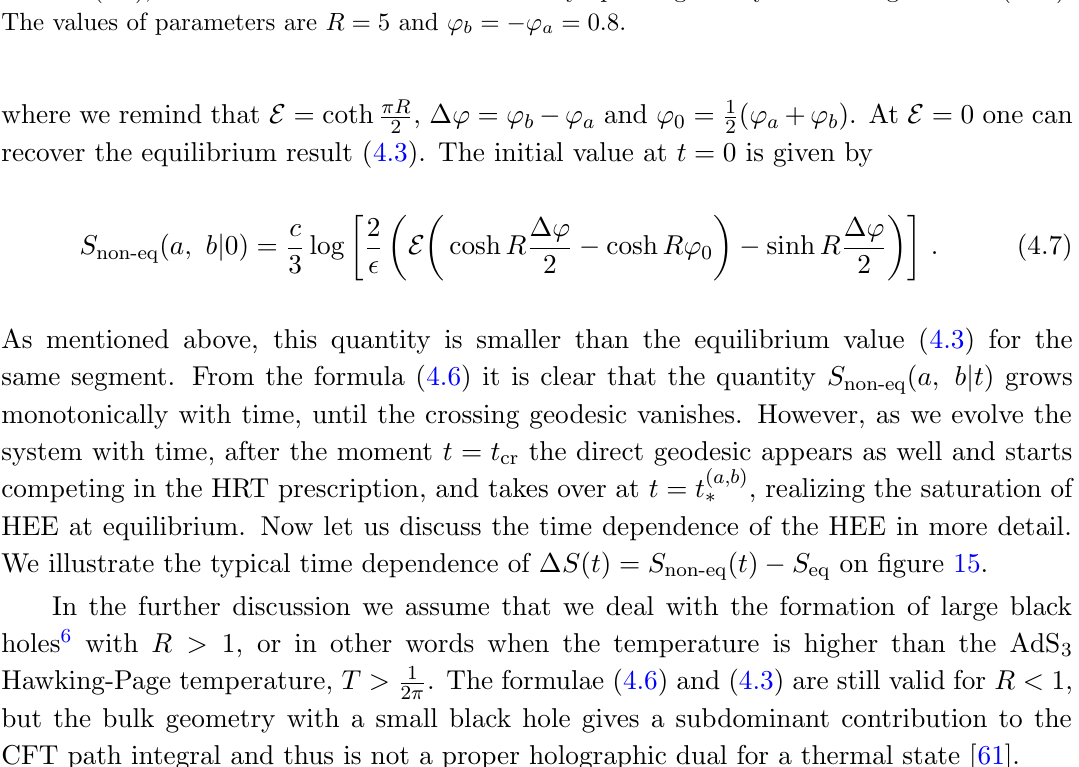
Figure 15 . Typical time dependence of HEE of a non-equilibrium subsystem. Here the dark red curve is the function (cid:1) S ( t ), green dashed curve is the quadratic approximation given by the leading term in (4.8), and blue dashed line is the linear asymptotic given by the leading term in